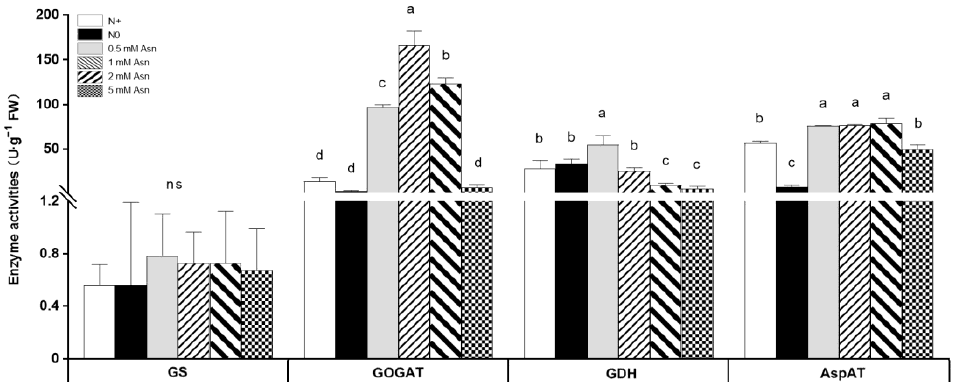
Figure 7. Effects of exogenous asparagine (Asn) on the activities of enzymes involved in N metabolism pathways in poplar ‘Nanlin895’ roots. GS, glutamine synthase; GOGAT, glutamate synthase; GDH, glutamate dehydrogenase; AspAT, aspartate aminotransferase. “N0” indicates N-free; “N+” represents the inorganic N control. The concentration of Asn applied was 0.5 mM, 1 mM, 2 mM, and 5 mM. Bars indicate means ± SD (n ≥ 3), and different letters indicate significant differences ( p < 0.05) based on Duncan’s test .